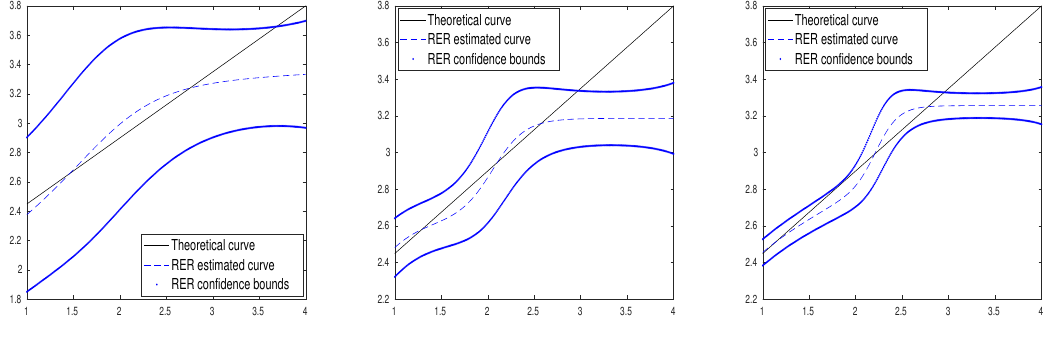
Figure 10: ρ 1 = 0.9 with CR ≈ 85% and n = 50, 200 and 400